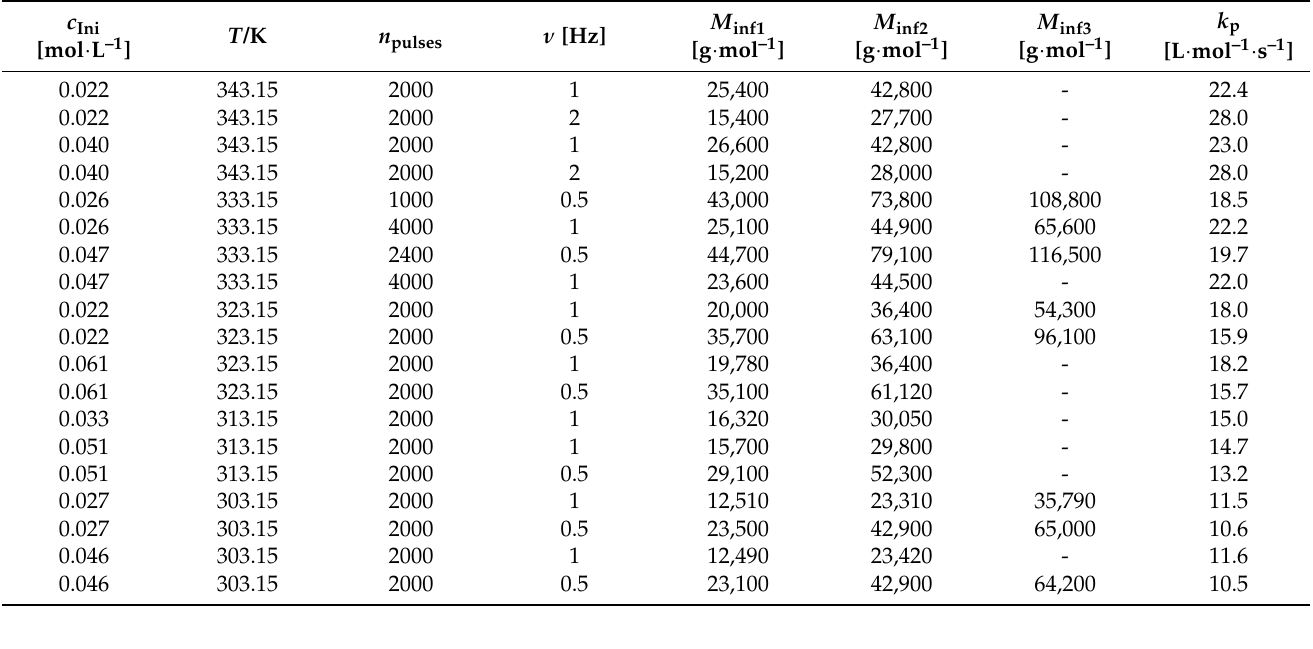
Table 2. PLP-SEC data for DEI: initiator concentration, c Ini , temperature T , total number of pulses, n pulses , laser pulse frequency, ν , molecular weight at the various inflection points, M inf , and the average k p of all obtained inflection points.